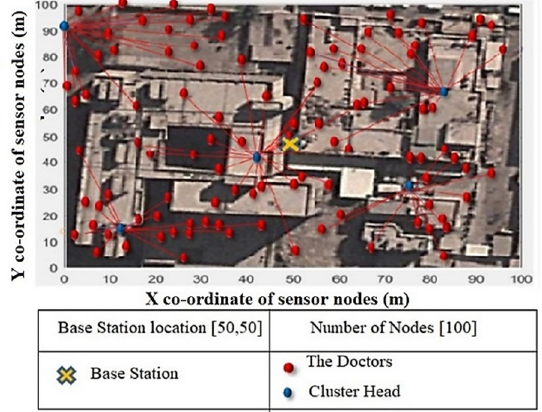
Fig. 12. Movement of doctors within the city of medicine after Clusters and Cluster head selection.